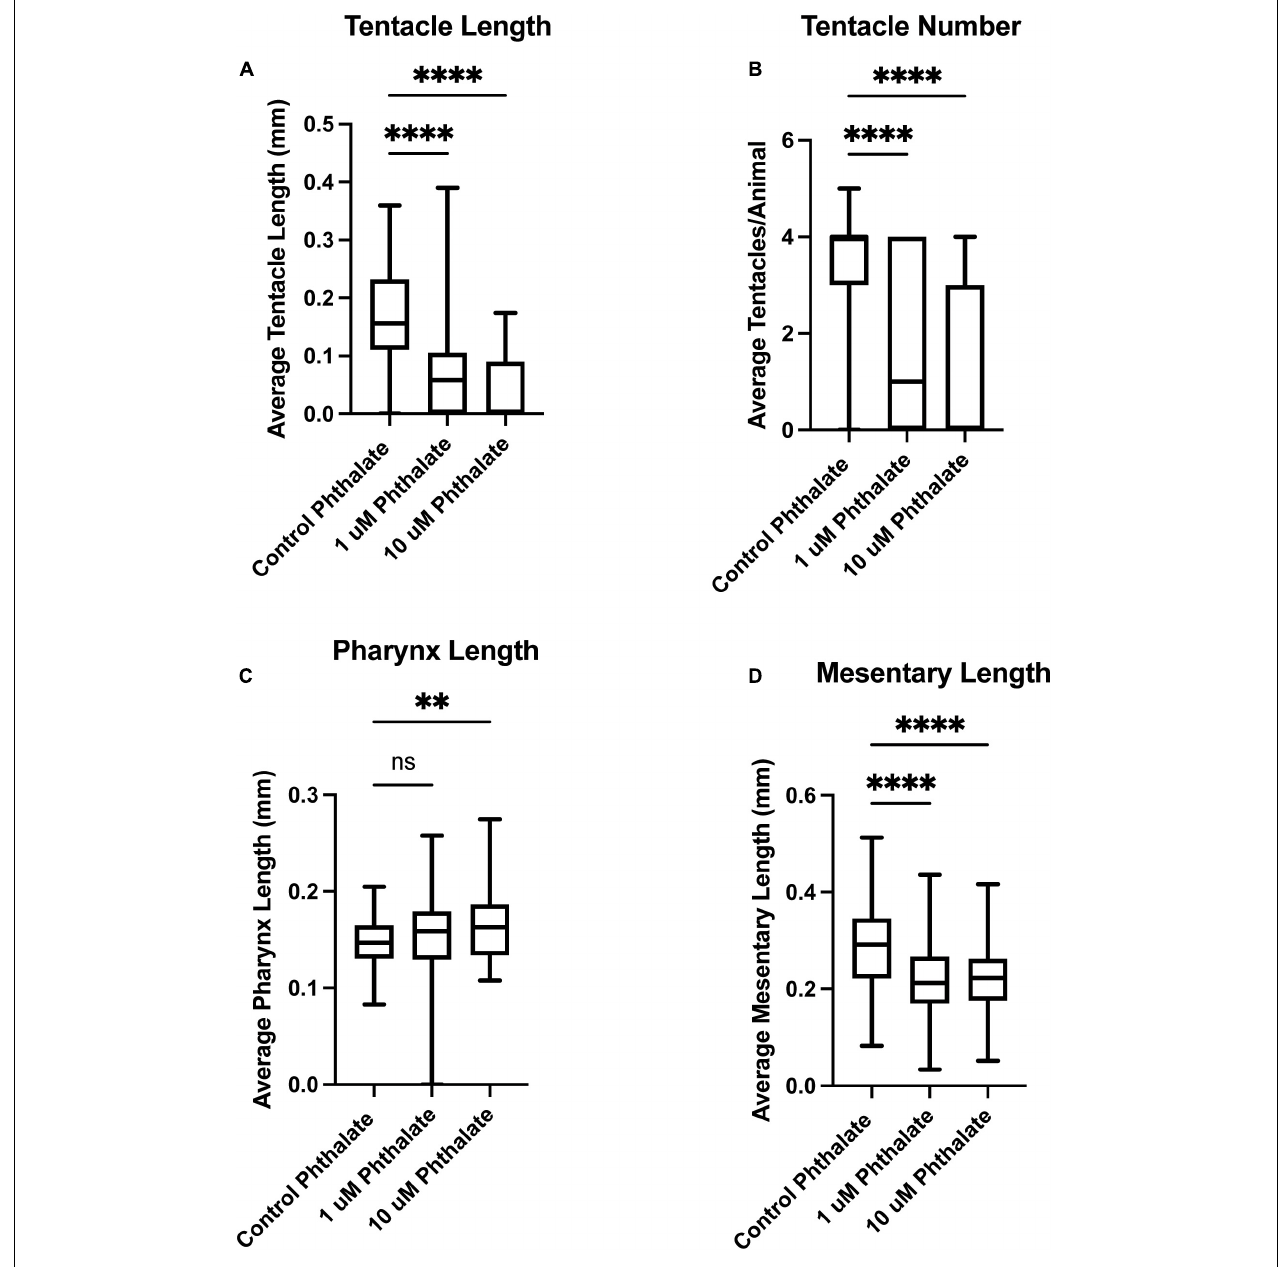
FIGURE 2 | Early exposure to phthalates leads to defects in tissue development. Two weeks post fertilization Nematostella have grown at least four tentacles and are independently feeding. Animals exposed to 1 or 10 µ M phthalate have much shorter tentacles (A) and developed fewer tentacles when compared to control animals (B) . The length of pharynx was also measured but no significant difference was found in overall length in comparison to sibling control animals at 1 µ M but at 10 µ M the pharynx was significantly shorter (C) . The overall length of the mesenteries was also found to be shorter in animals exposed to phthalates (D) .